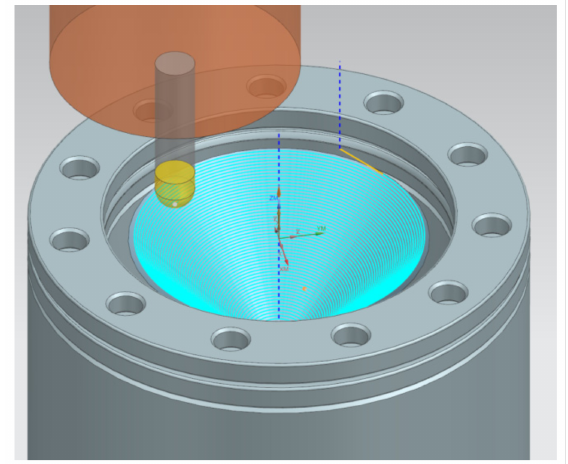
Figure 3. Tool path trajectory for a truncated